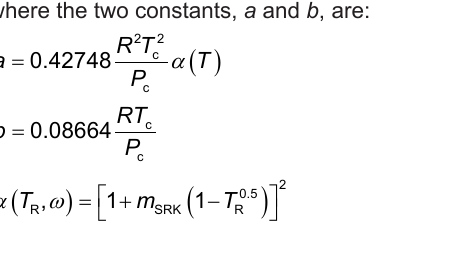
Table 4. Optimized binary interaction parameters ( k deviations in the vapor phase compositions ( AADY /%) for carbon dioxide and 2-methyl-1-propanol (isobutanol). T/K k